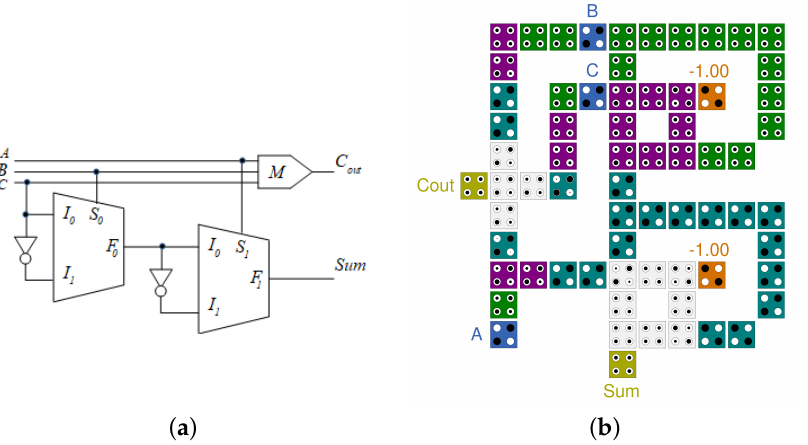
Figure 4. Full adder using MUX and Majority logic gates: ( a ) Abstract diagram; ( b ) QCA